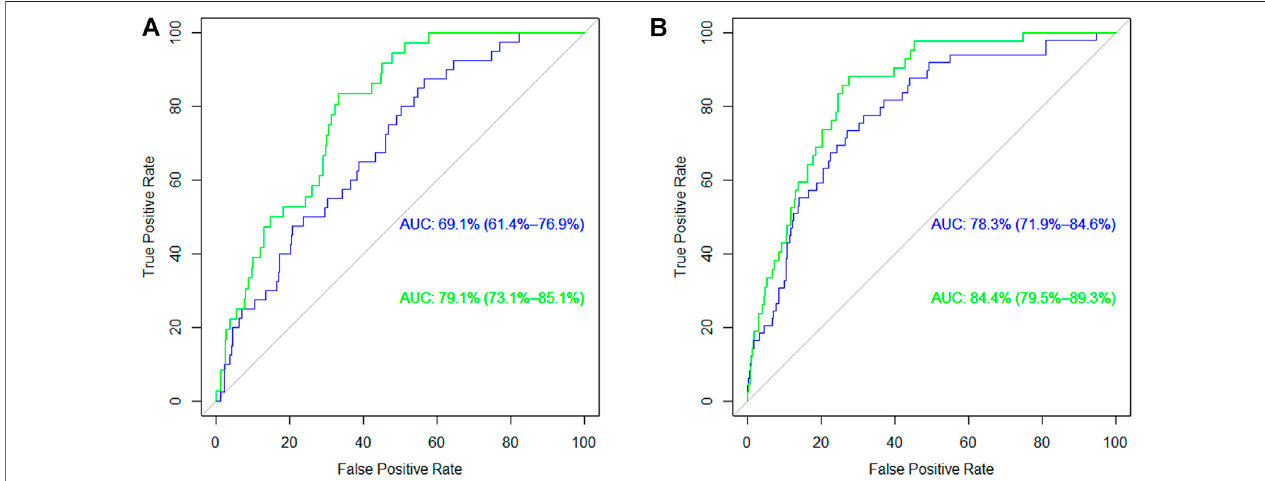
FIGURE 3 | Receiving Operating Curves for the risk of cardiovascular events in (A) nephrosclerosis patients and (B) the whole population of patients and controls. The blue line corresponds to the model with classic risk factors and the green line corresponds to the same model when genetic information is added. AUC, area under the curve.